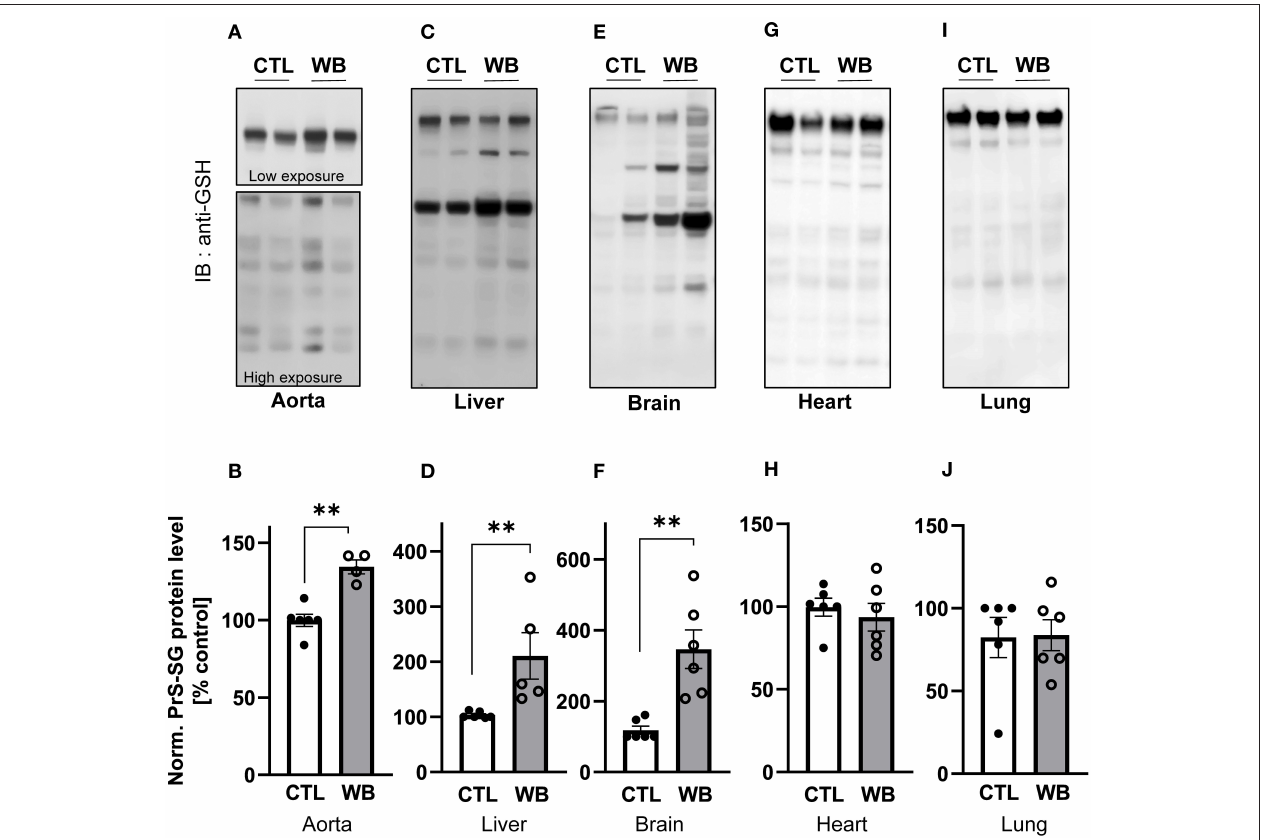
FIGURE 2 | Alcohol-binge drinking increases the protein S-glutathionylation in aorta, liver, and brain of ApoE − / − mice Protein S-glutathionylation (PrS-SG) level from ApoE − / − mice in (A,B) aorta; (C,D) liver; (E,F) brain; (G,H) heart and (I,J) lung tissue homogenate of control (CTL) and weekend-binge (WB) ethanol-fed mice were analyzed. Protein of different tissues were isolated and immunoblot under non-reducing conditions was performed. PrS-SG levels were detected with the anti-GSH antibody. (A,C,E,G,I) Representative immunoblot results and (B,D,F,H,J) densitometric analysis of PrS-SG signal intensity in the tissue lysate. Bars represent mean ratio ± error propagated S.E.M. ( n = 4–6, Student t test, ** p <